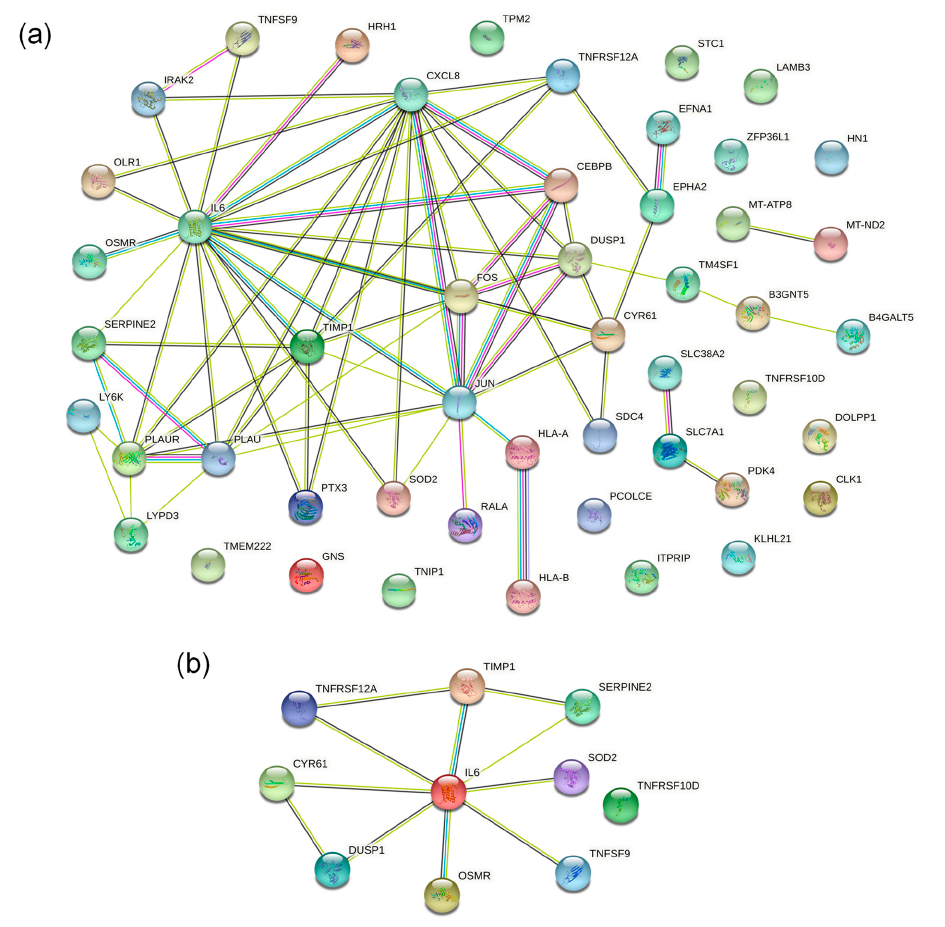
Figure 5. Protein–protein interaction (PPI) network analysis of DEPs. ( a ) PPI network results of 50 DEPs. IL6, TIMP1, CXCL8, DUSP1, and other DEPs played a central role; ( b ) PPI network results of 10 key DEPs. IL6 plays a significant regulatory role in the 10 key DEPs.